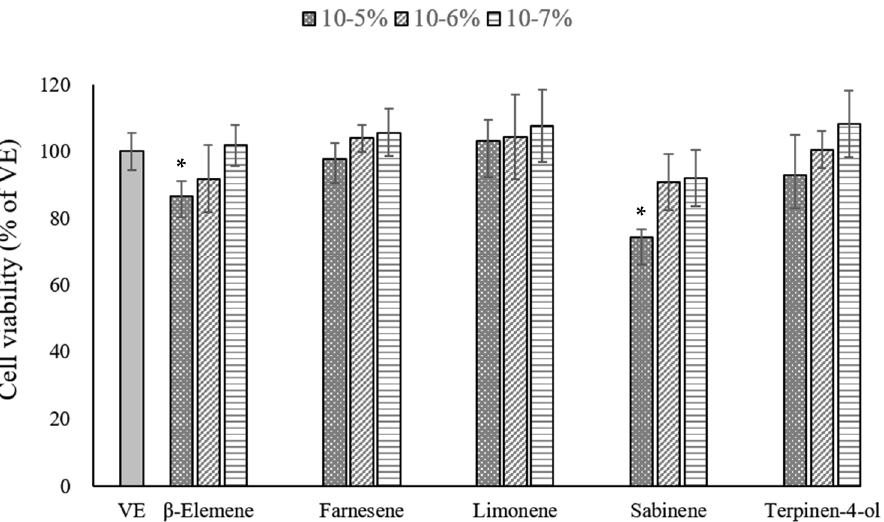
Figure 6. Cell viability assessed using the CCK assay. Values are presented as means ± standard deviations. Note: * p < 0.05 compared to VE. VE: vehicle group.